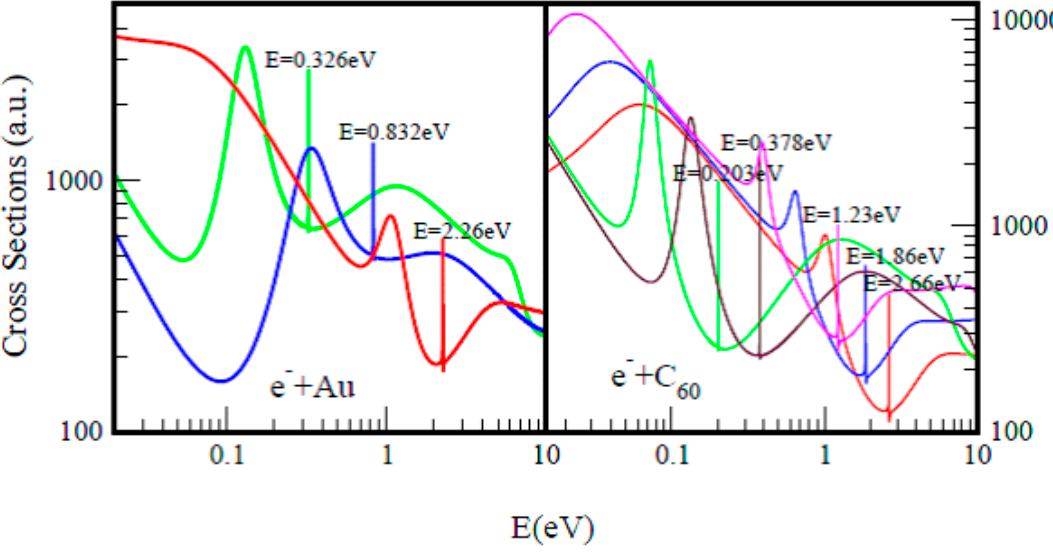
Figure 1. The standard total cross sections (TCSs) (a.u.) for electron elastic scattering from atomic Au (left panel) and the fullerene molecule C 60 (right panel) are contrasted. For atomic Au, the red, blue and green curves represent TCSs for the ground, metastable and excited states, respectively. For the C 60 fullerene, the red, blue and pink curves represent TCSs for the ground and the metastable states, respectively, while the brown and green curves denote TCSs for the excited states. The dramatically sharp resonances in both figures correspond to the Au ˉ and C 60 ˉ negative ions formation during the collisions.